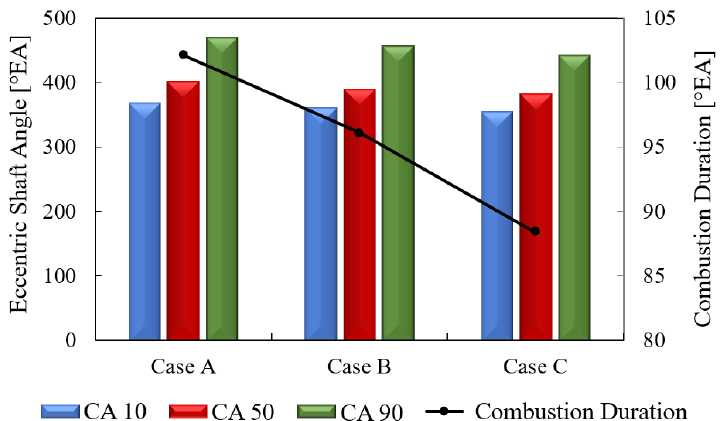
Figure 10. Comparison of CA 10, CA 50 and CA 90 occurrence positions and combustion duration for different cases.